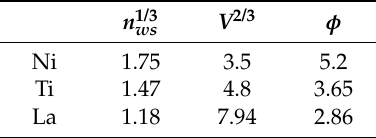
Table 2. Parameters of Ti, Ni, and La for formation enthalpy